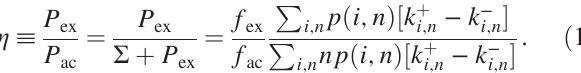
1 , and ac ¼ . The limit of small ex (dotted max ex